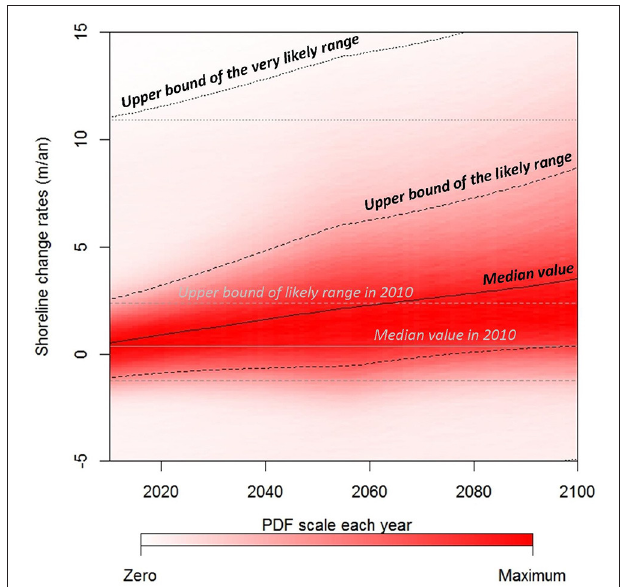
FIGURE 3 | Shoreline retreat rate projections for the 21st century, with no prior information regarding the type of sandy coast considered, the impacts of man-made infrastructures and the climate change scenario. Positive values corresponds to shoreline retreat. For each date, the intensity of the color represents the probability density function, and the solid, dashed and dotted black lines represent the median, likely, and very likely ranges. The gray lines represent present days rates: they are extended toward the whole 21st century for comparison. They represent a virtual case in which sea-level remains at its present level, whereas the black lines take into account uncertain sea-level rise scenarios of Figure 1 using the Bruun